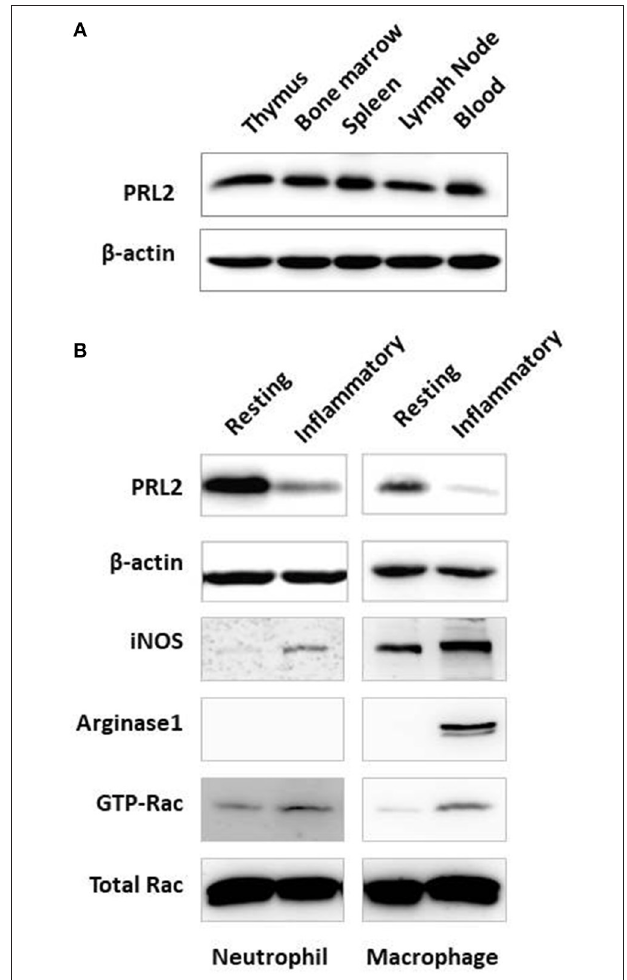
FIGURE 1 | Expression of PRL2 in murine immune tissues and cells. (A) Lysates of mouse immune tissues were subjected to SDS-PAGE followed by immunoblot analysis using the indicated antibodies. (B) Neutrophils were purified from naïve mouse bone marrow (resting) or abdominal cavity exudate (inflammatory) as described in Material and Methods. Resting and inflammatory macrophages were collected from naïve mice or from the peritoneal cavity after thioglycollate-elicited peritonitis, respectively. Cell lysates were subjected to SDS-PAGE followed by immunoblot analysis using the indicated antibodies. Data are representative of two or three independent